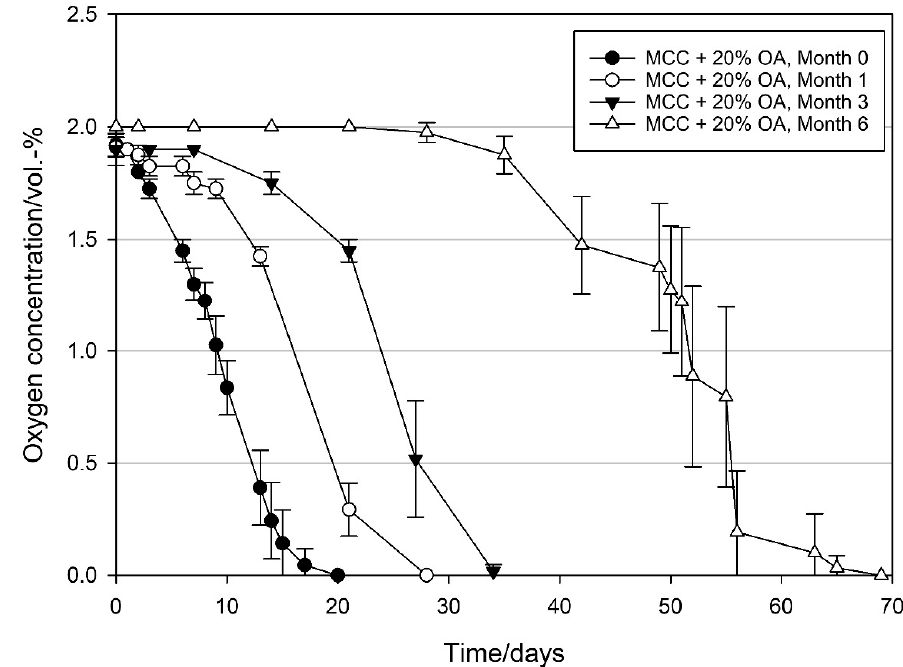
Figure 10. Oxygen scavenging concentration of modified calcium carbonate (MCC) loaded with 20 wt% oleic acid packed under modified atmosphere (MAP, 2 vol.-% O 2 , rest N 2 ; headspace 250 mL), ~50% RH in the package and stored at 21 °C. Freshly produced oleic acid loaded MCC and same batch after one, three, and six months of storage at 21 °C under nitrogen and in the dark. Mean values and standard deviation (n = 4).